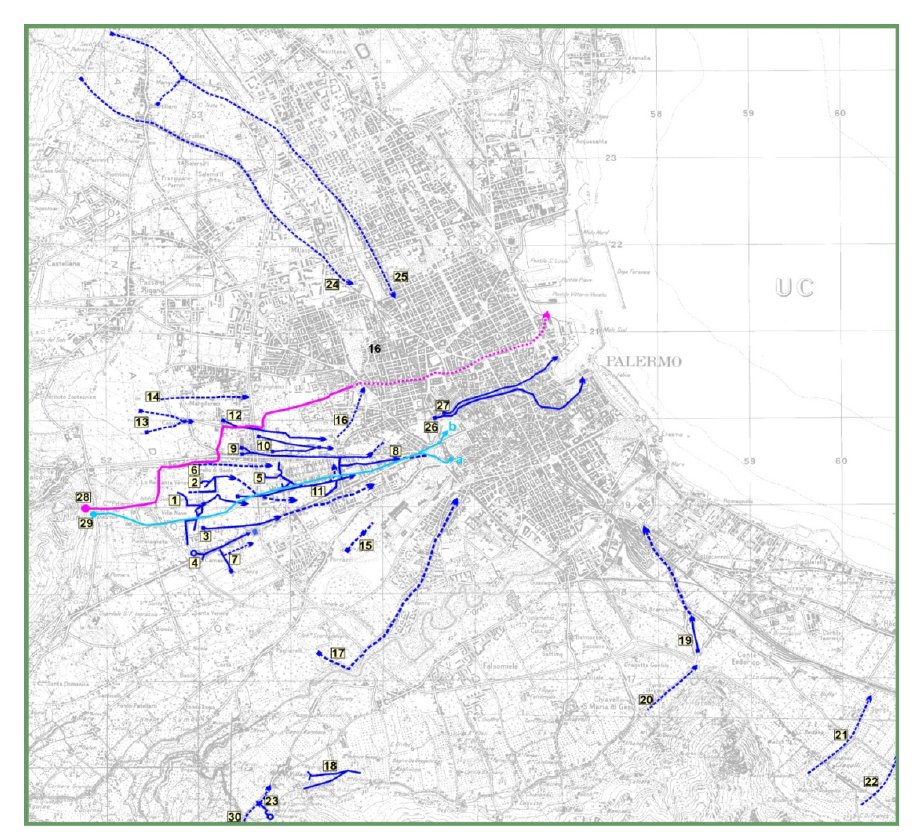
Figure 4. List of 25 qan ā ts together with 5 surface canals located in the hydrological basin of the Palermo Plain (adopted from Todaro [2]). Dashed lines: The paths are only indicative and hypothesized, unexplored and unrecognized. Purple lines: Historical irrigation canals of Mezzomonreale Plain . Blue light lines: Water supply system ( incatusato